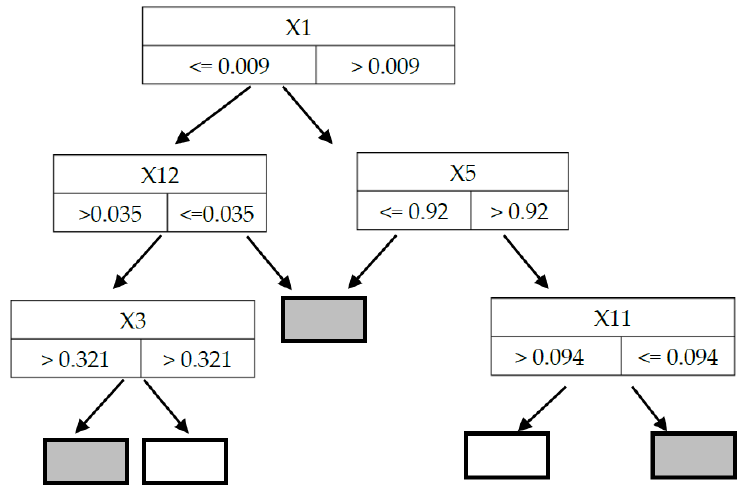
Figure 5. The structure of the Classification and Regression Tree (C&RT) model for Far-East Asian households. Gray box indicates consumers at risk of insolvency. White box indicates consumers at high financial health. Source: based on own studies.